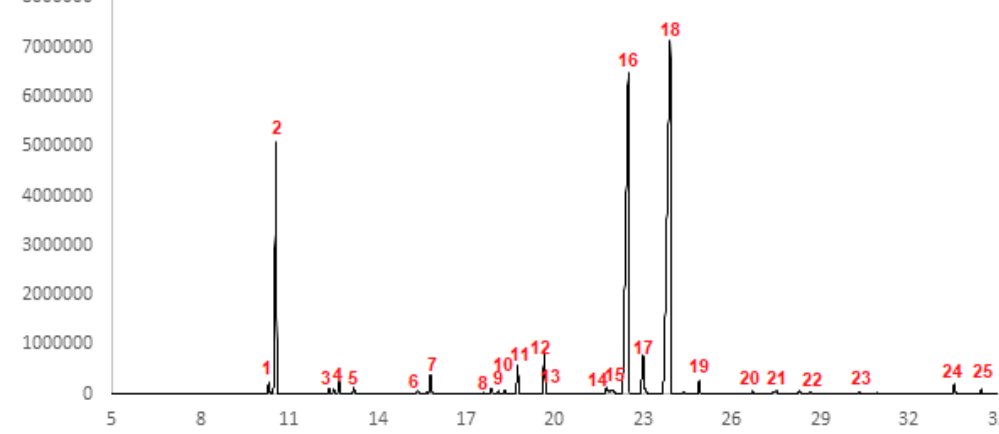
Figure 1. GC-MS Chromatogram for Cymbopogon citratus essential oil. Each number corresponds to a chemical constituent found in EOCc detailed in Table 1.